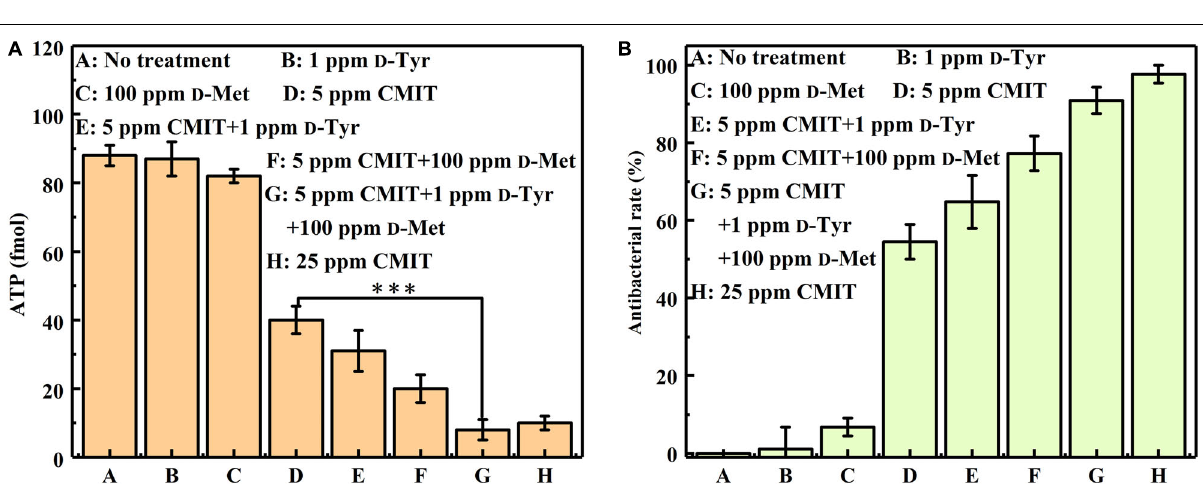
Frontiers in Microbiology |